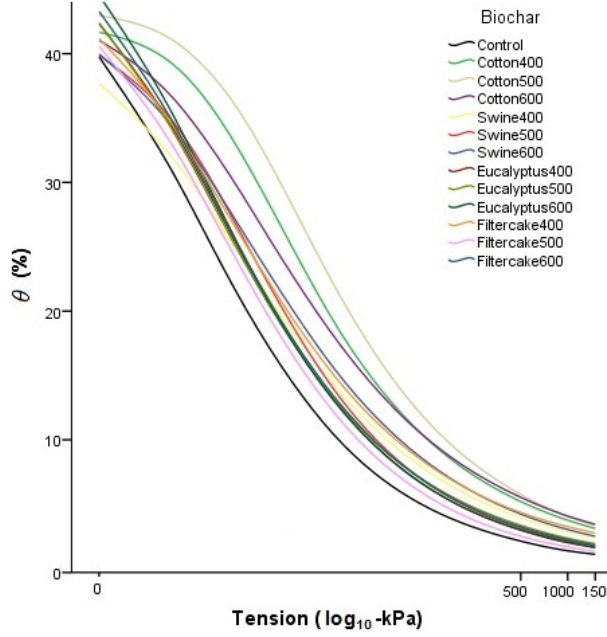
Figure 4. Water retention curves of intact soil cores ( n = 4).